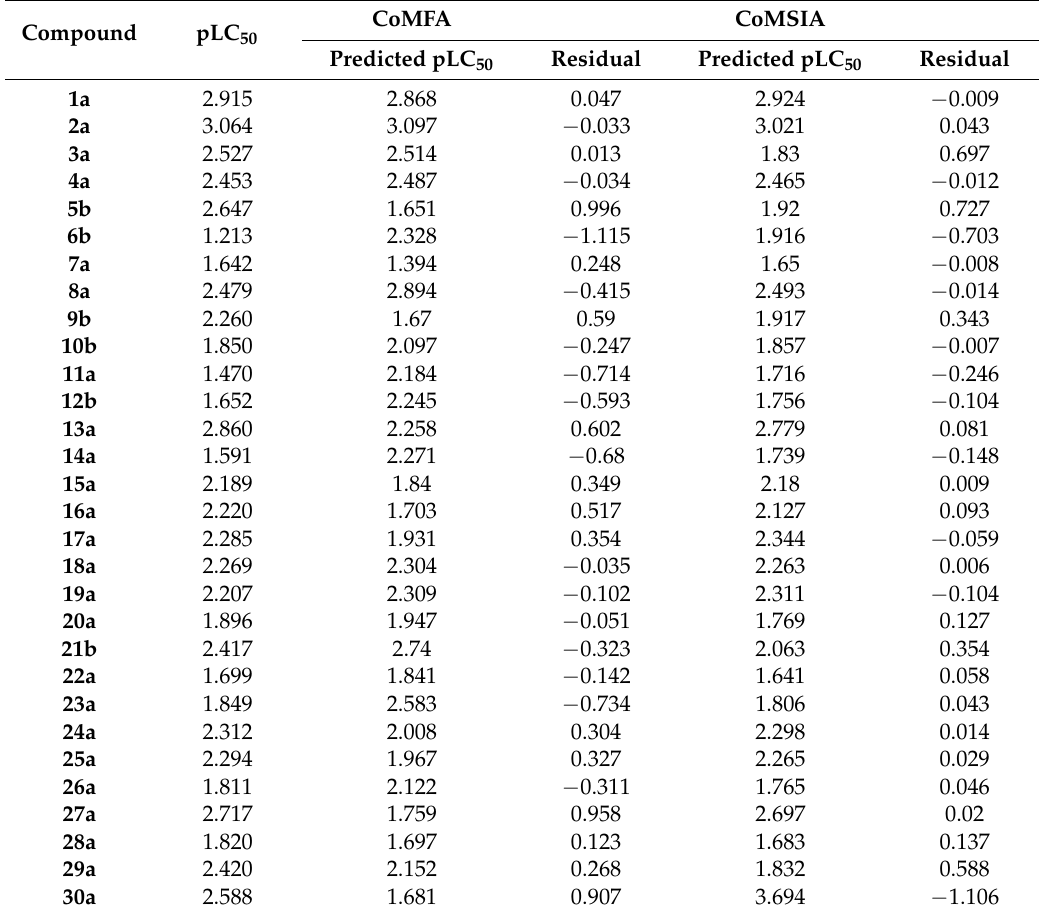
Table 4. Observed and predicted activities of the test